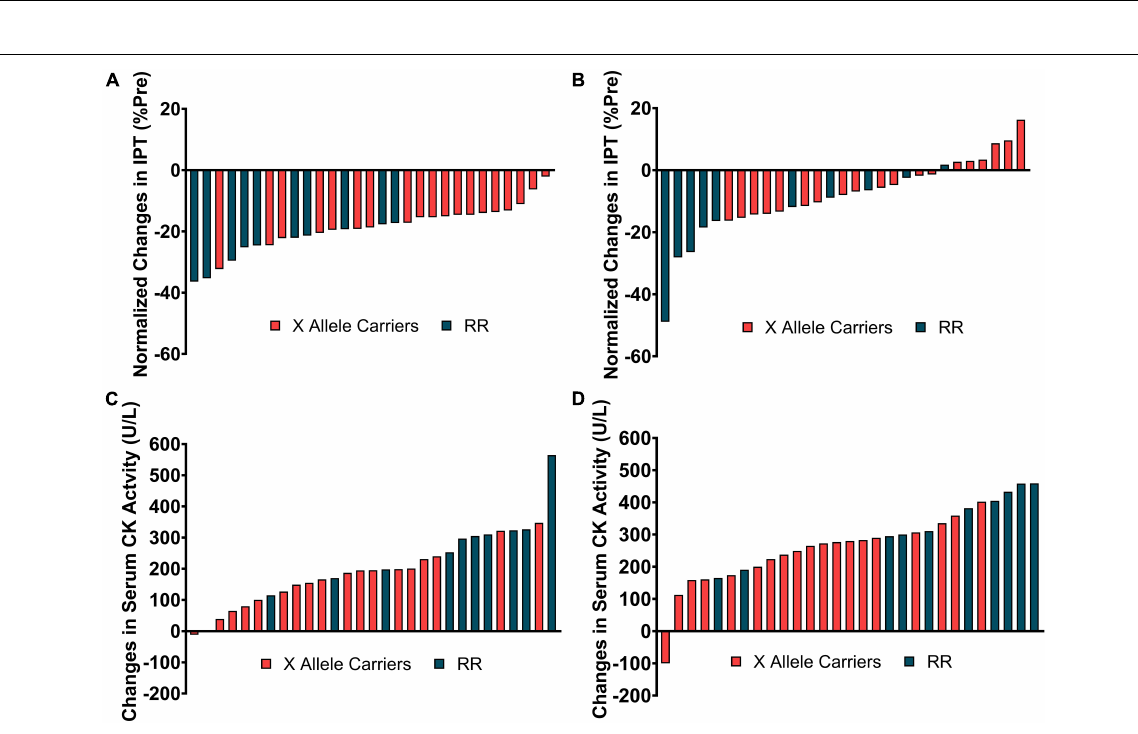
Frontiers in Physiology |